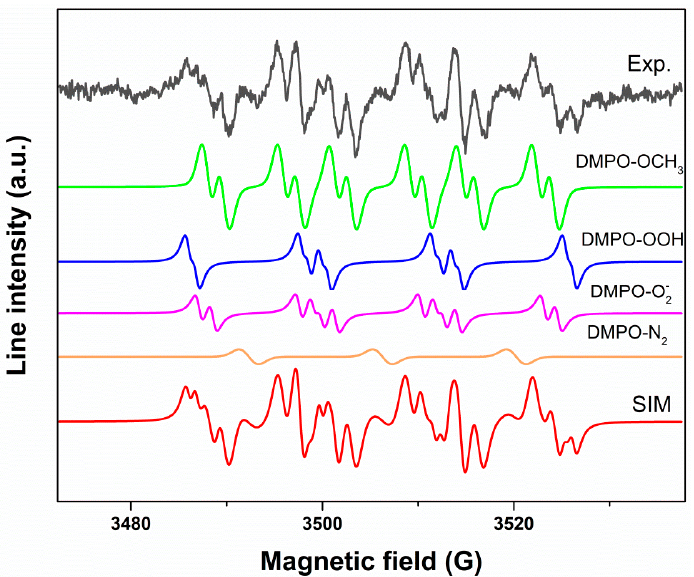
Figure 14. Experimental and simulated spectra of DMPO spin adducts generated by the ZnO-Au1 sample after 25 min of visible irradiation.